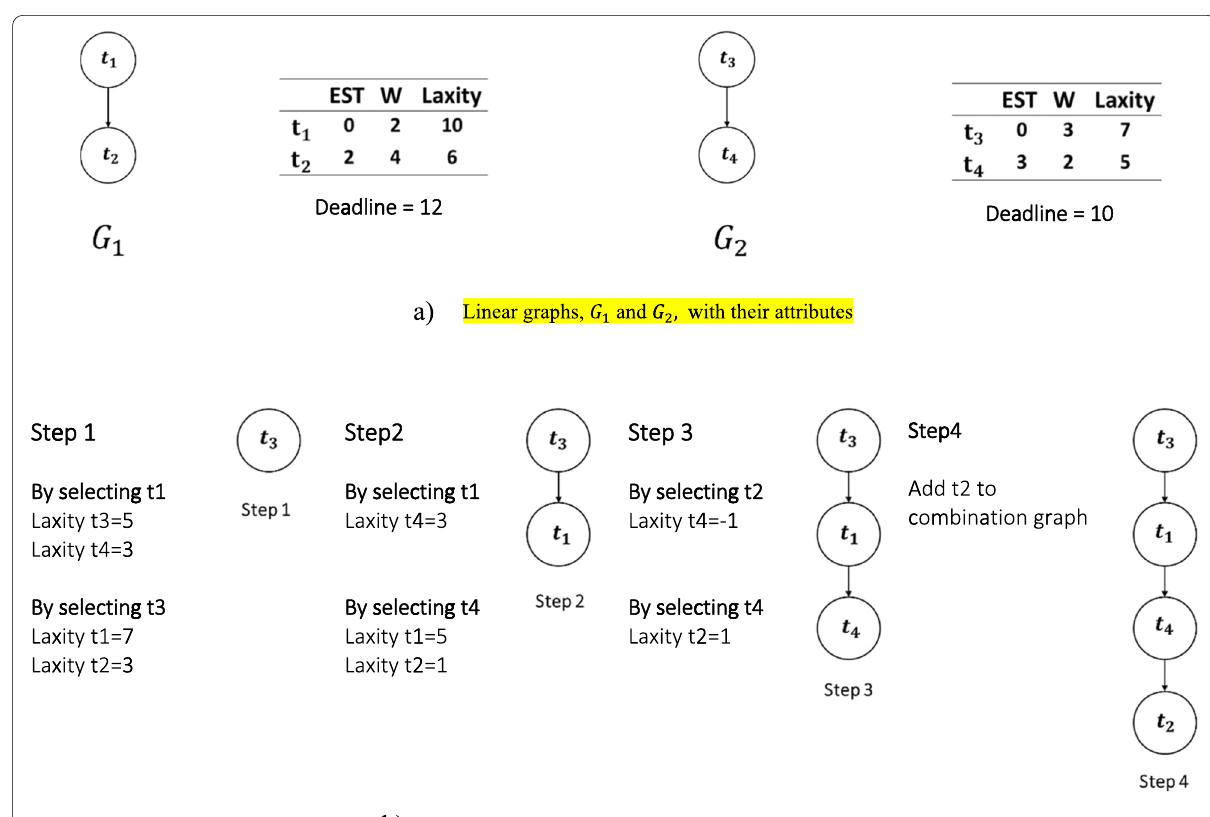
Fig. 9 Illustrative example for combining two linear